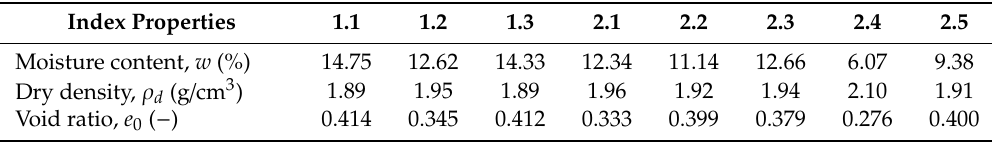
Table 2. The cyclic triaxial test soil sample index properties.